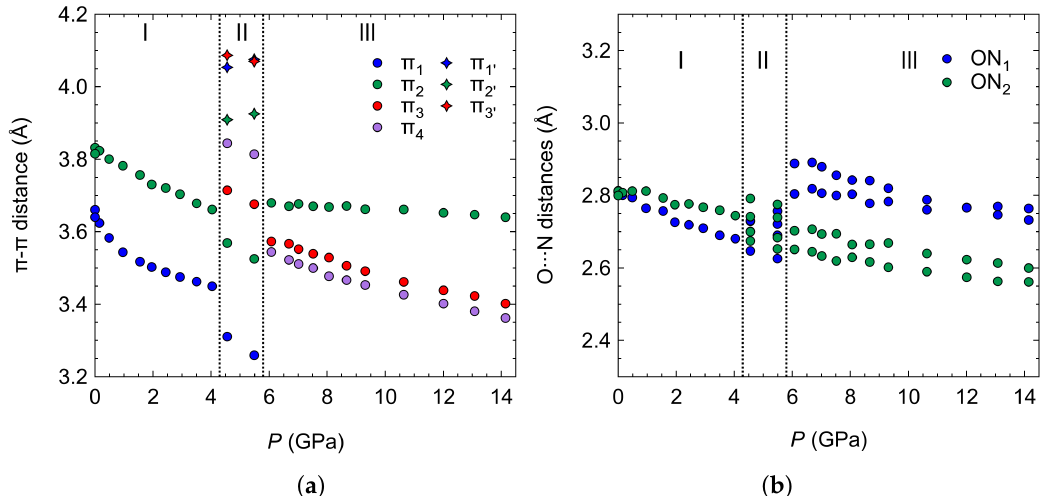
Figure 8. ( a ) The π − π distances on compression between the two initially parallel 4HCB molecules (which are symmetry related in the Pbcn phase), where the labels indicate the interactions depicted in Figure 7. ( b ) O · · · N hydrogen bonding distances on